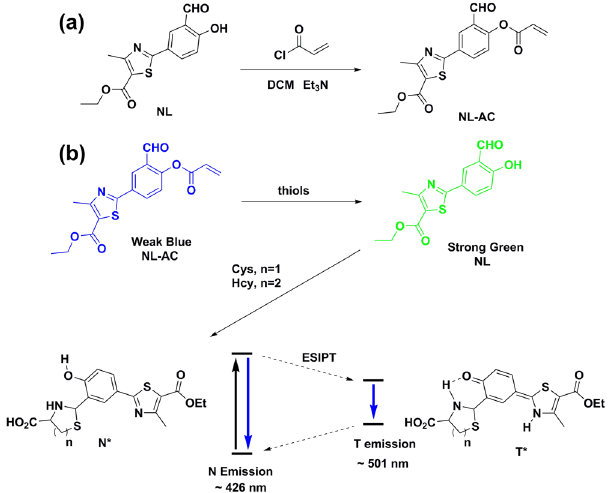
Figure 1. ( a ) Synthesis of the NL-AC probe and ( b ) chemical structures of NL-AC and biothiols along with a schematic representation of the ESIPT process of NL with